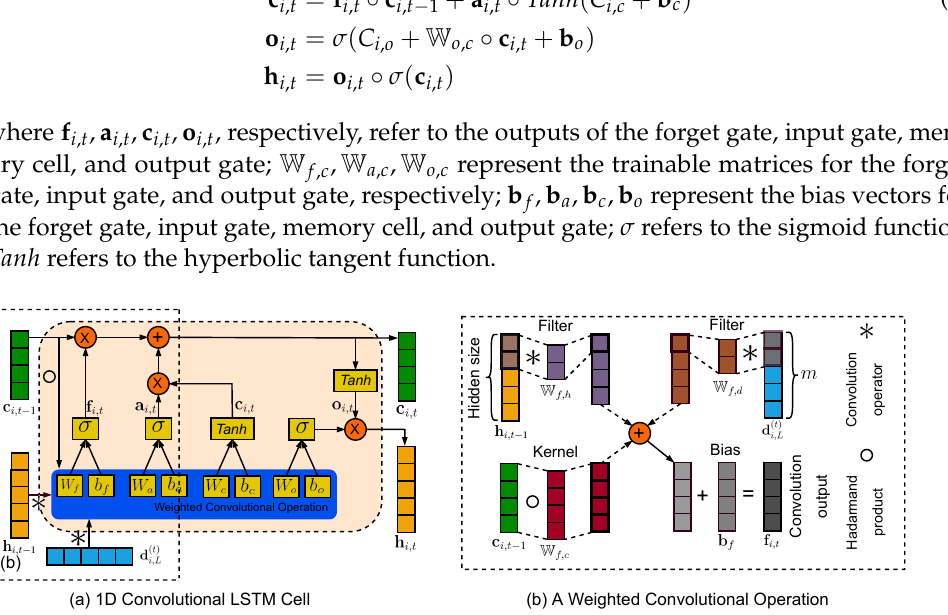
Figure 2. The framework of the one-dimensional convolutional LSTM cell with weighted convo- lutional operations, where ( a ) is the 1D convolutional LSTM cell and ( b ) gives an example of the weighted convolutional